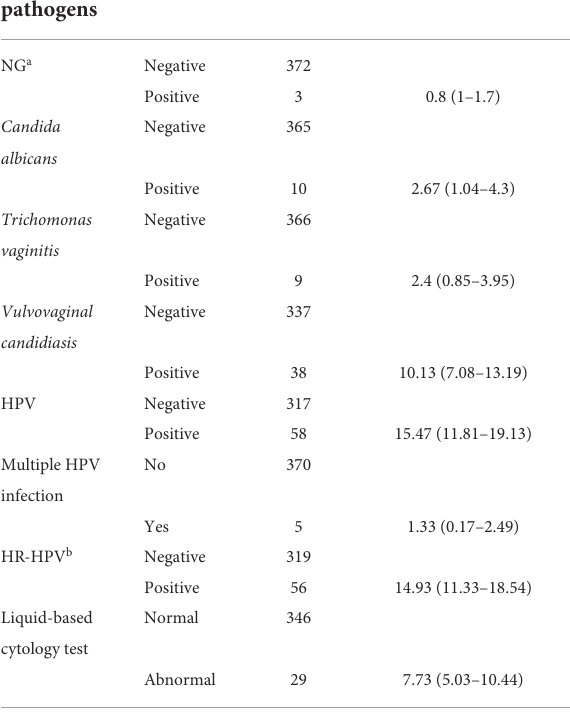
TABLE 2 C.trachomatis coinfection with other STIs.